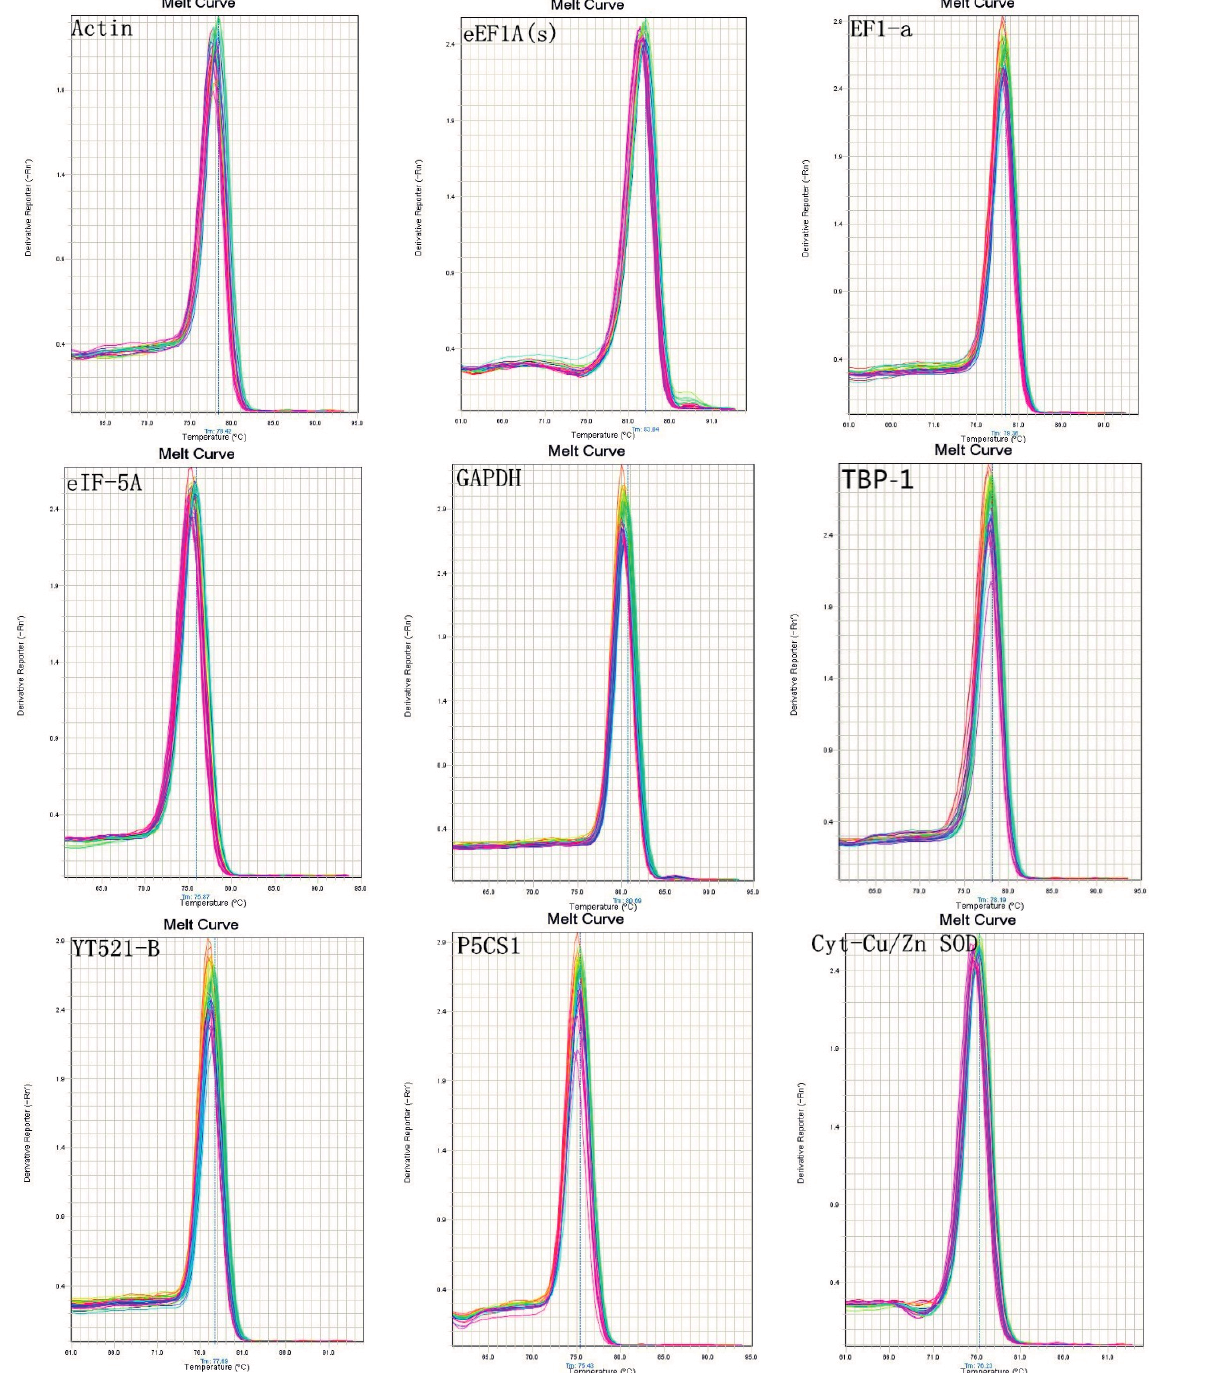
Figure 2. Melt curves of nine